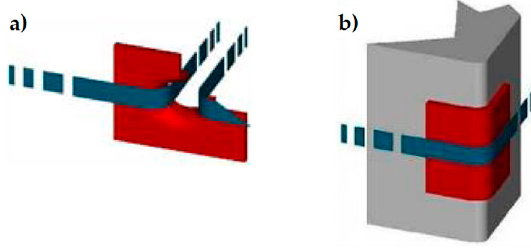
Figure 7. Protective elements of the CAM system: ( a ) funnel plates and ( b ) rounded angles.